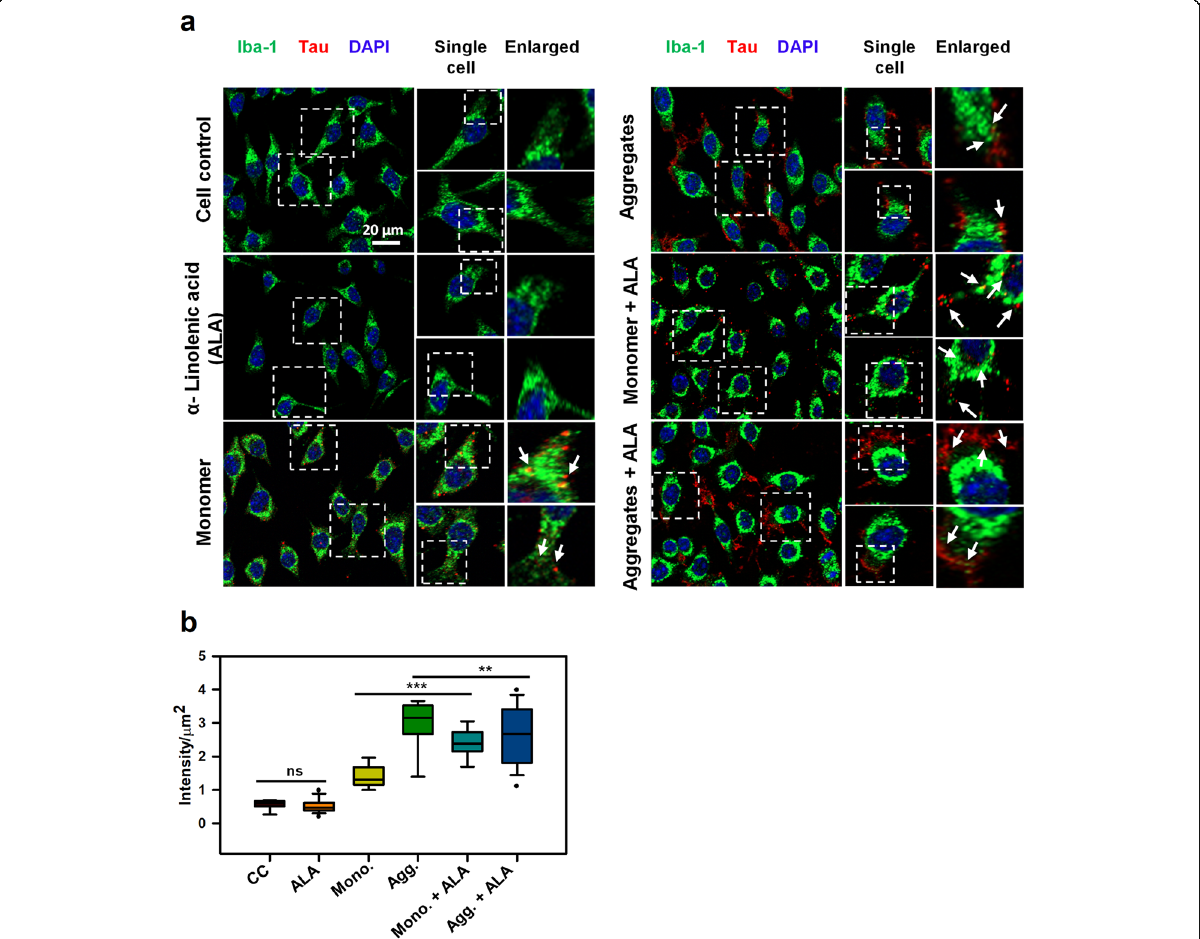
Fig. 2 Internalization of extracellular Tau in Microglia. a Study of internalization of extracellular Tau monomer and aggregates in the presence of ALA. The treatment was given for 24 h and studied with fluorescence microscopy to understand the internalization of Tau (red) in Iba-1 (green) positive cells. Figure showing fluorescence microscope image, single cell and enlarged panel indicates that the internalized Tau denoted with white arrow marks. The enlarged region is highlighted with white dotted square that indicates internalized area in the cells. Axio observer 7.0 Apotome 2.0 Zeiss microscope was used to the study of internalization extracellular Tau. b Quantification of internalized Tau was carried out with a total intensity of Tau (red) per μ m 2 area inside the cell was analyzed by ZEN 2.3 software. The significance was analyzed with Tukey ’ s Kramer, significant when mean difference between treatment groups (X-X ’ ) > T (Tukey ’ s criteria). The significance of conditions of Tau monomer and aggregtes with ALA is p < 0.005. annotations used in graph are as follows- CC (Cell control), ALA ( α -linolenic acid), Mono. (monomer), Agg. (aggregates), Mono. + ALA (monomer plus ALA), Agg. + ALA (aggregates plus